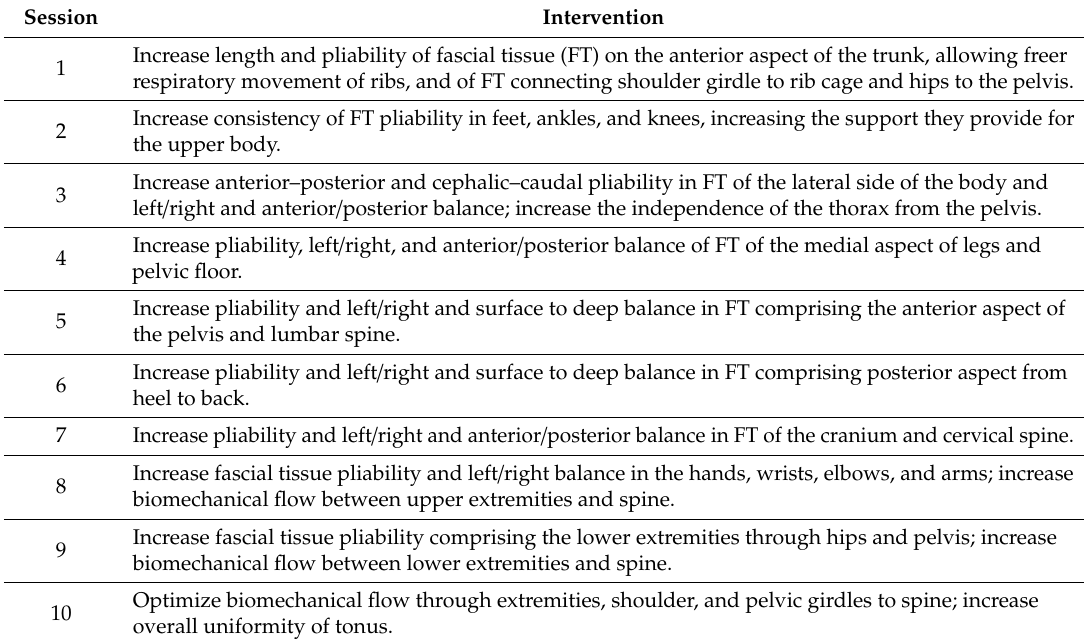
Table 1. Description of ten Structural Integration (SI) interventions